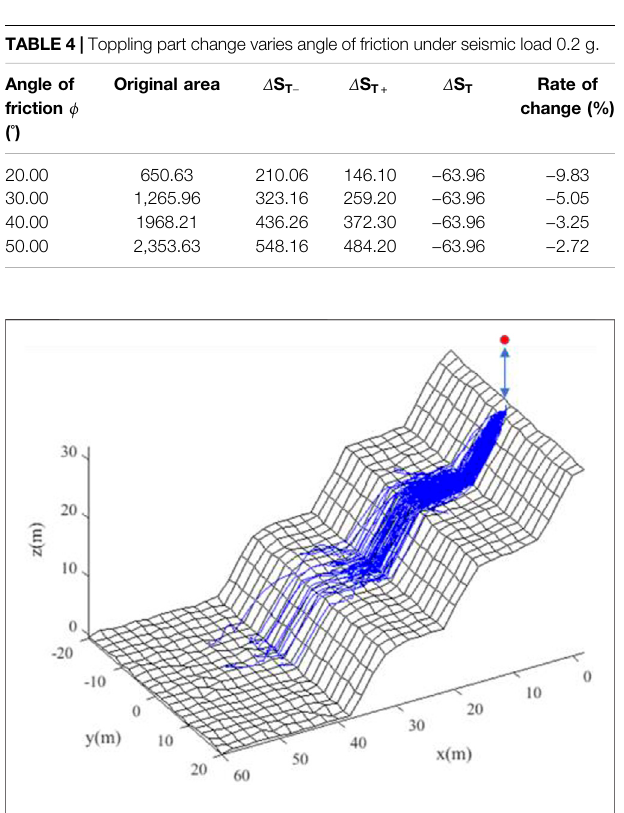
FIGURE 7 | Numerical experiment design.